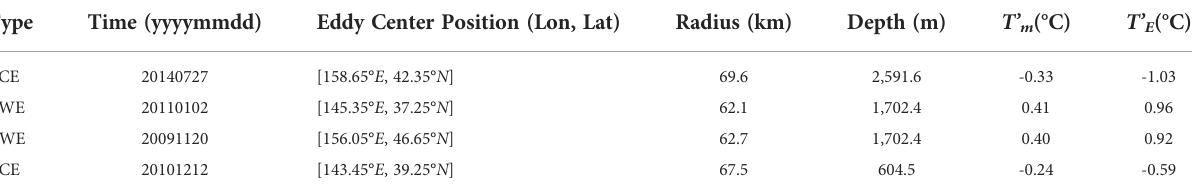
TABLE 1 Basic information of the four types of eddy cases*.